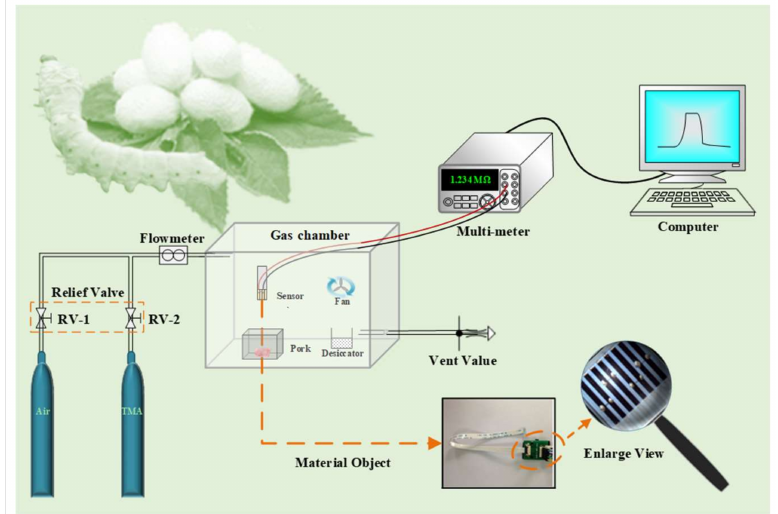
Figure 1. Schematic diagram of gas-sensing device and the photos of